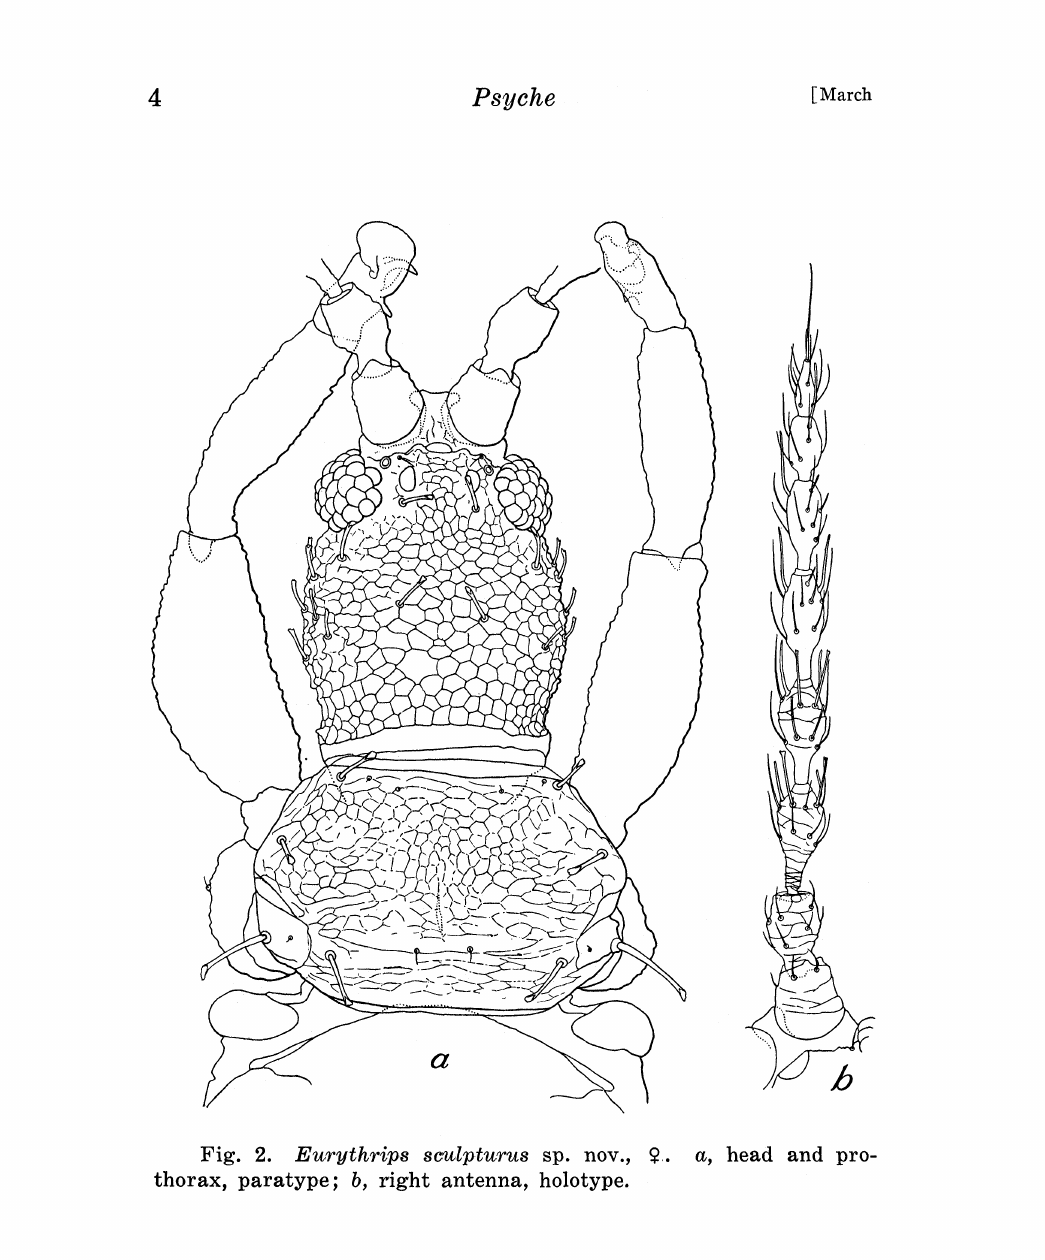
Fig. 2. Eurythrips sculpturus sp. nov., 9,. a, head and pro- thorax, paratype; b, right antenna,